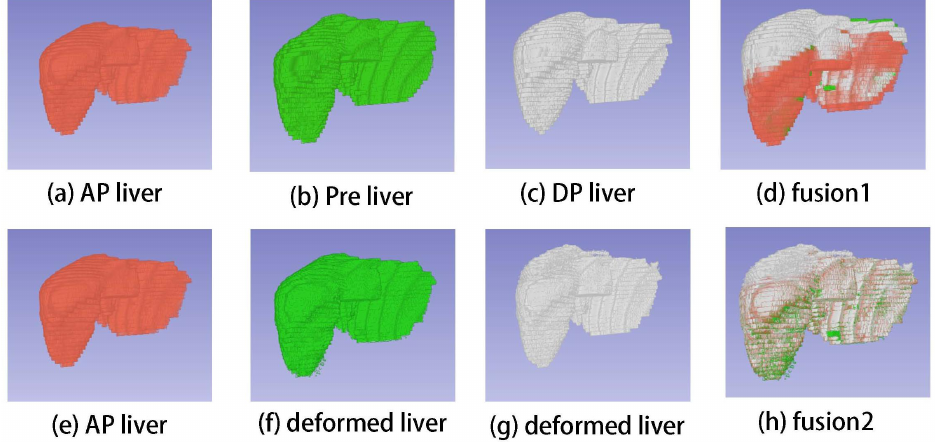
Figure 6. Three-dimensional view: ( a – c ) are fused together to show in ( d ); ( f ) shows deformed Pre liver, ( g ) shows deformed DP liver; and ( e – g ) are fused together to show in ( h